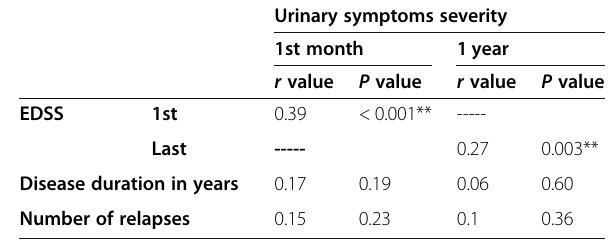
Table 5 Correlation of urinary symptoms severity with EDSS (1st month vs 1st EDSS, 1 year vs last EDSS), disease duration, and number of relapses